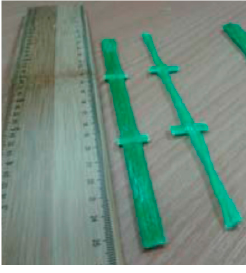
Figure 6. Specimens obtained from the 66 × 66 mm 2 GFRP grid.